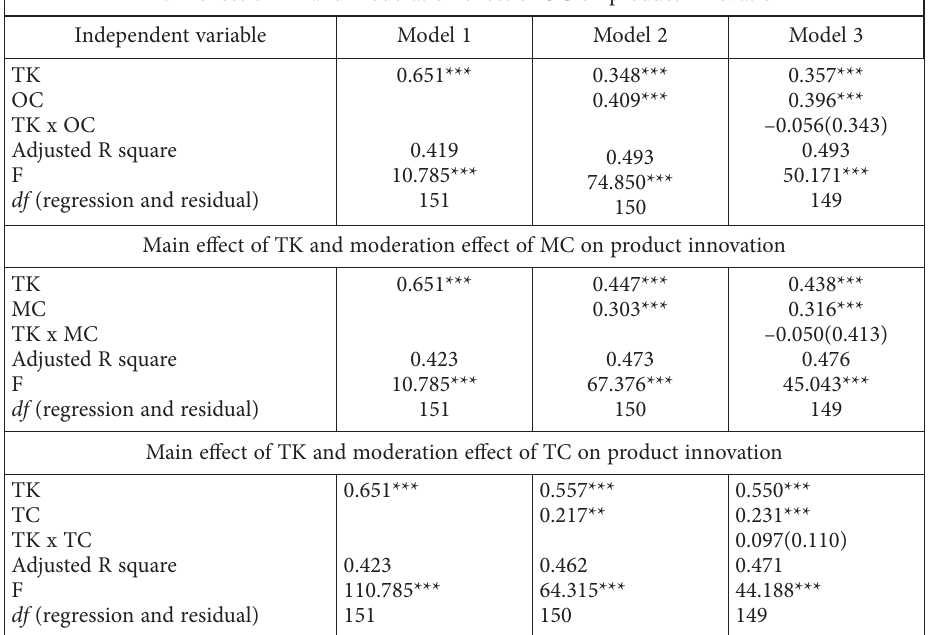
Table 4. Moderation